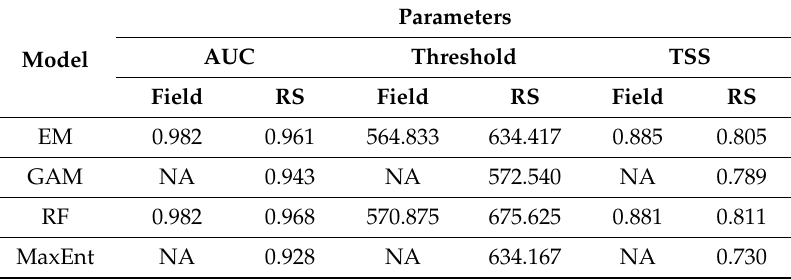
Table A3. Ecological niche modelling performances. The GAM and MaxEnt rows for the Field columns are NA because the TSS and AUC from these were less than 0.7 and 0.8 so we excluded these models from the analysis.